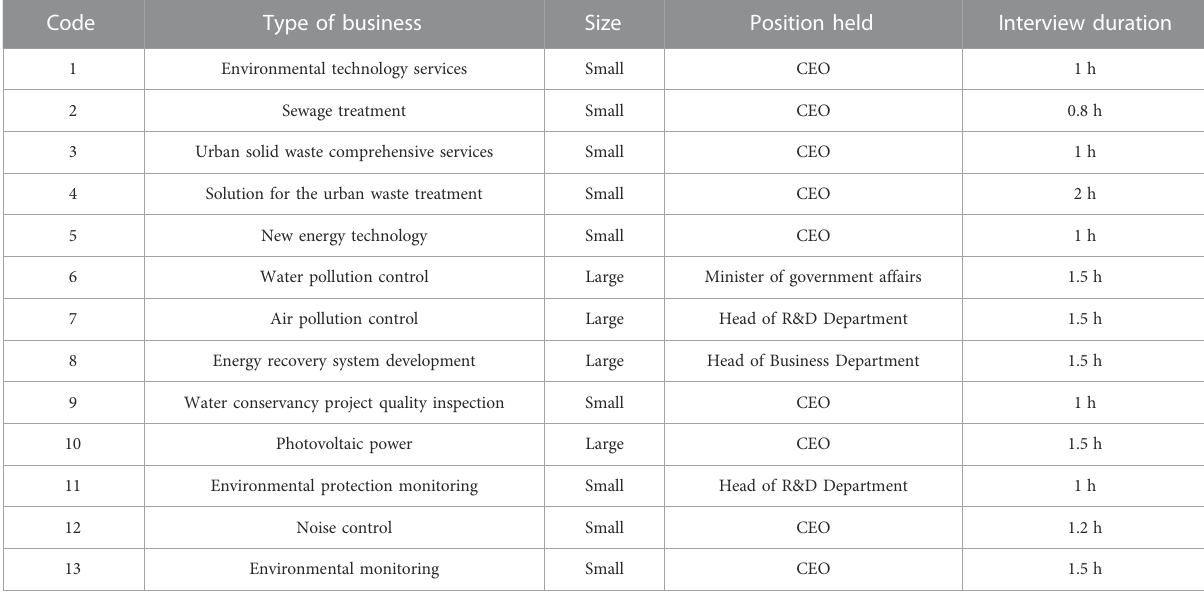
TABLE 2 Anonymized overview of the interview participant details.